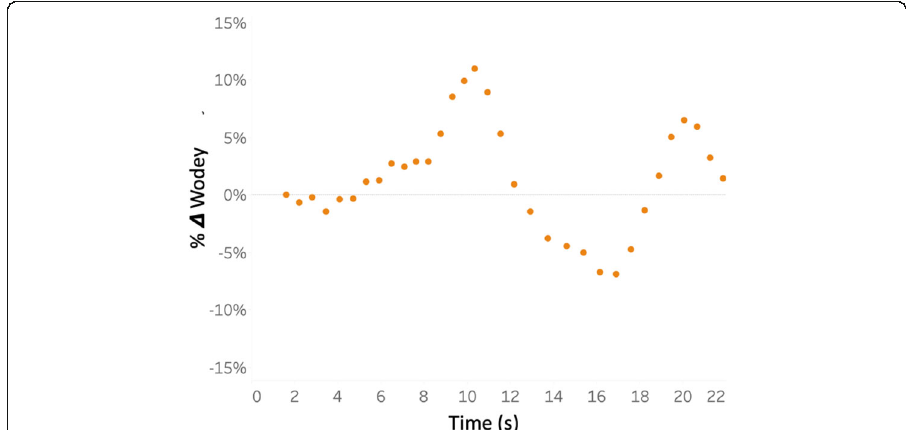
Fig. 3 Respiratory variation in a representative subject. The percentage change in Ftc Wodey about the mean ( y -axis) is illustrated for a single subject during 20 s ( x -axis) of quiet